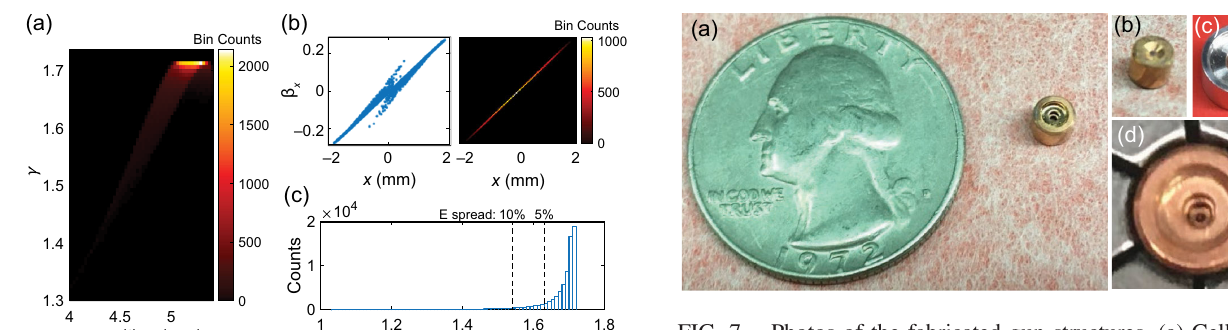
FIG. 7. Photos of the fabricated gun structures. (a) Cells with the coupling opening pointed up. The coupling iris and inner iris are both visible. (b) Back of the structure showing a divot for centering and alignment in the final assembly. (c) Cell structure upright in an aluminum adapter for cold testing. (d) Close-up photo where inner features are visible. The copper tip is visible in the center and the inner iris is also